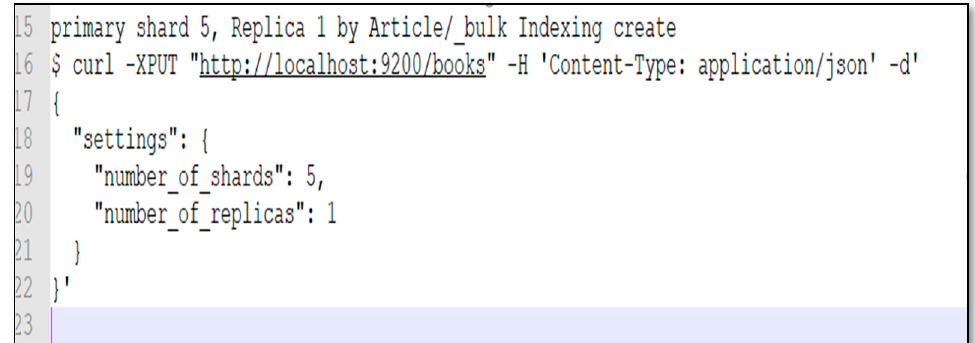
Figure 1. Primary shard